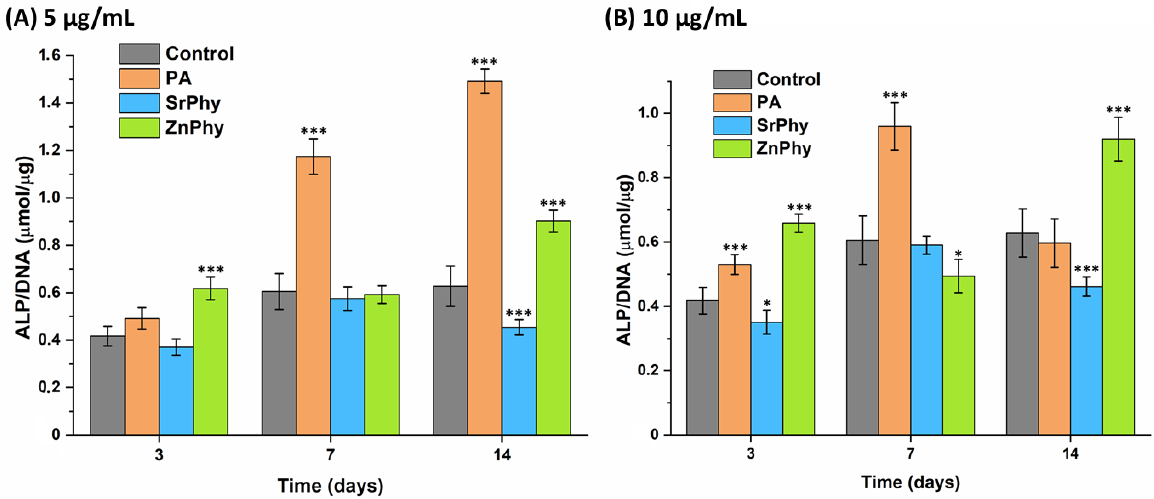
Figure 7. Quantitative assessment of ALP activity found in the hMSC cultures after 3, 7 and 14 days of treatment with PA, SrPhy and ZnPhy under a dose of ( A ) 5 µg/mL and ( B ) 10 µg/mL. The data were normalized against DNA content measured using a PicoGreen dSDNA quantitation kit. An ANOVA test was performed between the samples and the control group (osteogenic-DMEM) at each study time to establish the statistical differences at significant levels (* p < 0.05, *** p < 0.001; Tukey’s test). The results are expressed as the mean ALP/DNA ( µ mol/ µ g) ± SD ( n = 3).